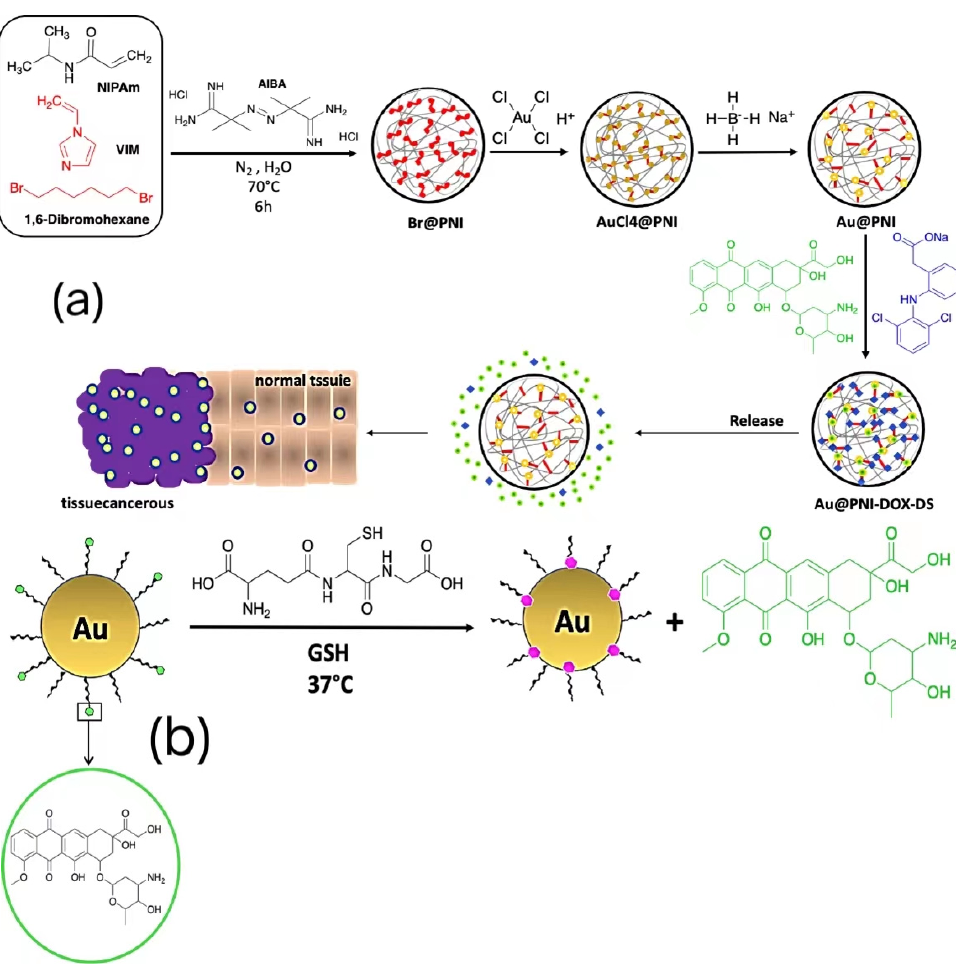
Figure 18. Framework for the ( a ) reaction mechanism developed by Zhou et al. and ( b ) the release profile of doxorubicin (DOX) on the surface of the functionalized gold nanoparticles.